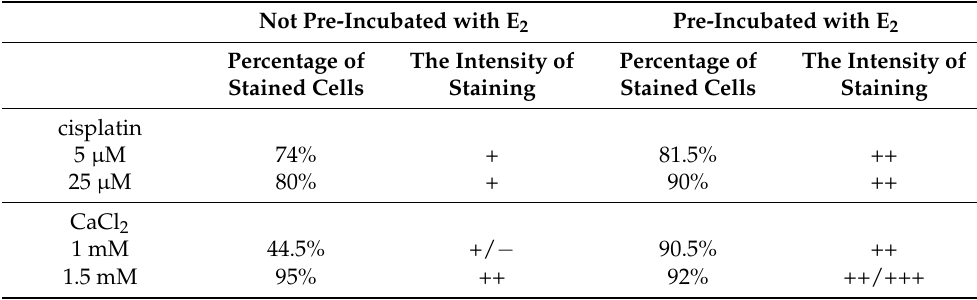
Table 2. The caspase-12 expression after exposure to cisplatin (5 µ M and 25 µ M) and CaCl 2 (1 mM and 2.5 mM) in the MDAH-2774 cell